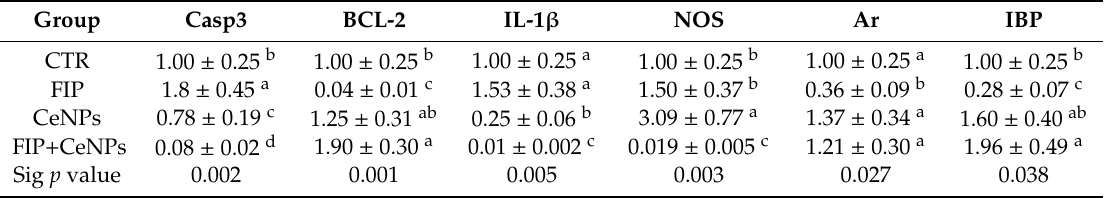
Table5. ThelevelsofrelativemRNAexpressionofapoptoticgenes(Casp3andBCL2), anti-inflammatory genes (IL-1 β and NOS), Ar, and IBP in the testes of rats.